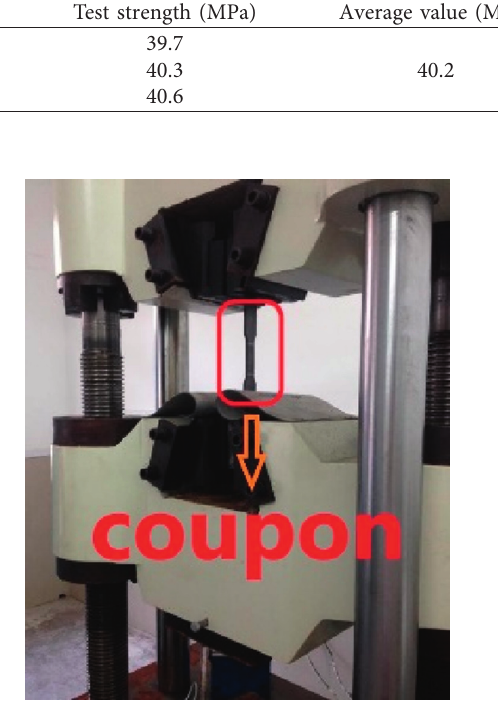
Figure 3: Test of steel standard